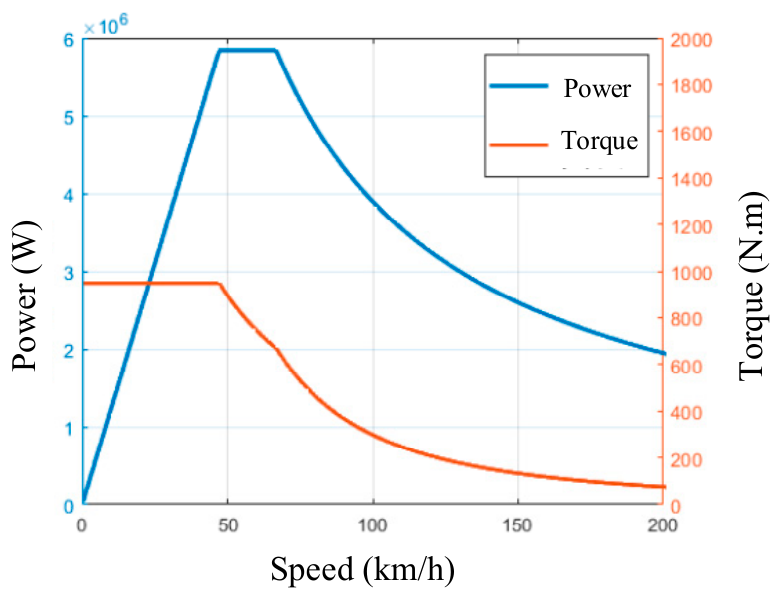
Figure 6. Electromechanical characteristics of traction motor.